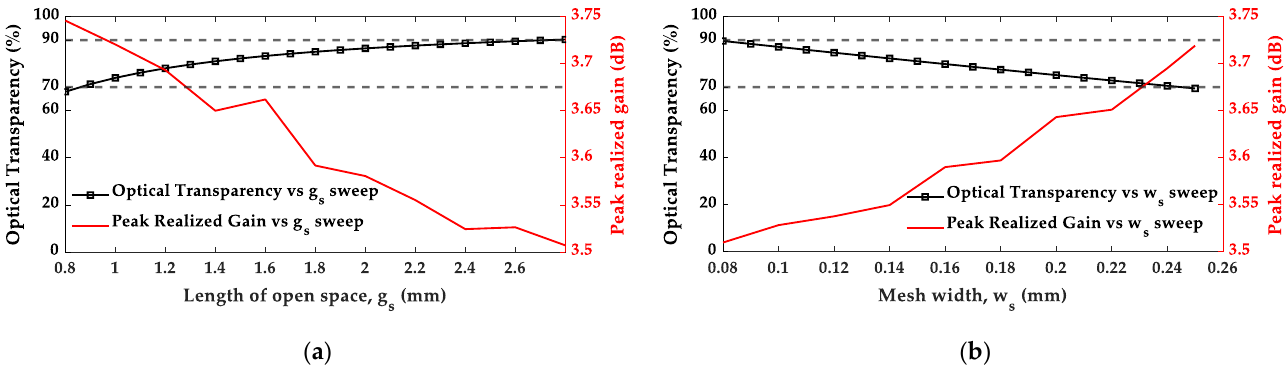
Figure 9. Effect of square mesh on peak realized gain: ( a ) length of the open space, 𝑔 𝑠 ; ( b ) mesh width, 𝑤 𝑠 .